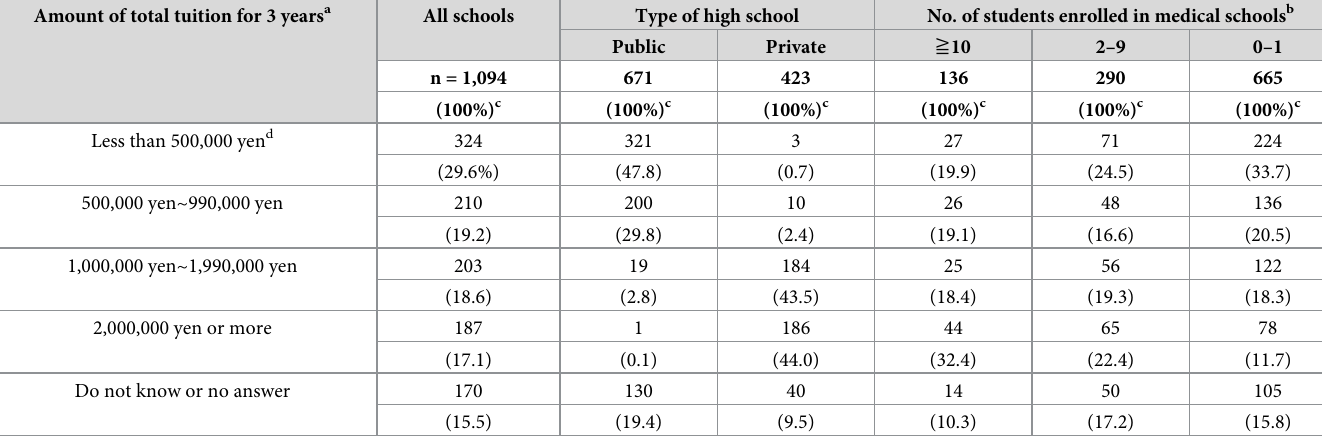
Table 2. Relationship between total tuition fees of high schools and their attributes (school type and number of students enrolled in medical schools). Amount of total tuition for 3 years